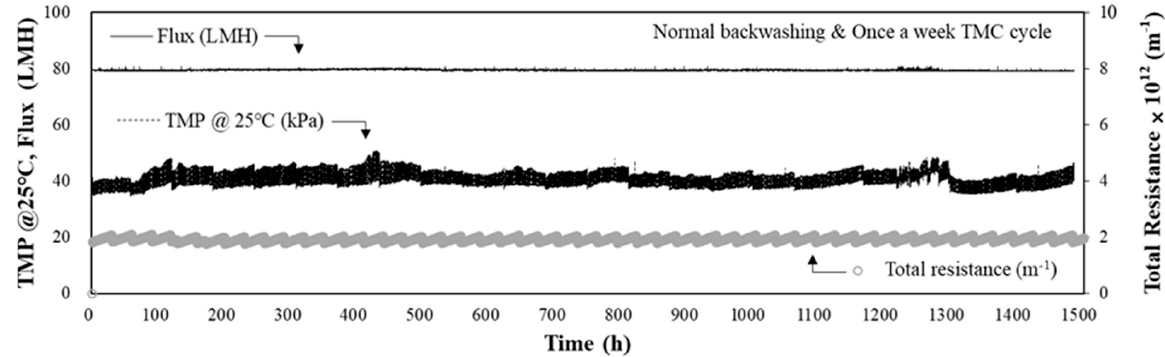
Figure 4. TMP and total resistance during the operation of MF-alone process with low-turbidity raw water (max. turbidity = 13.4 NTU, flux = 80 LMH) .